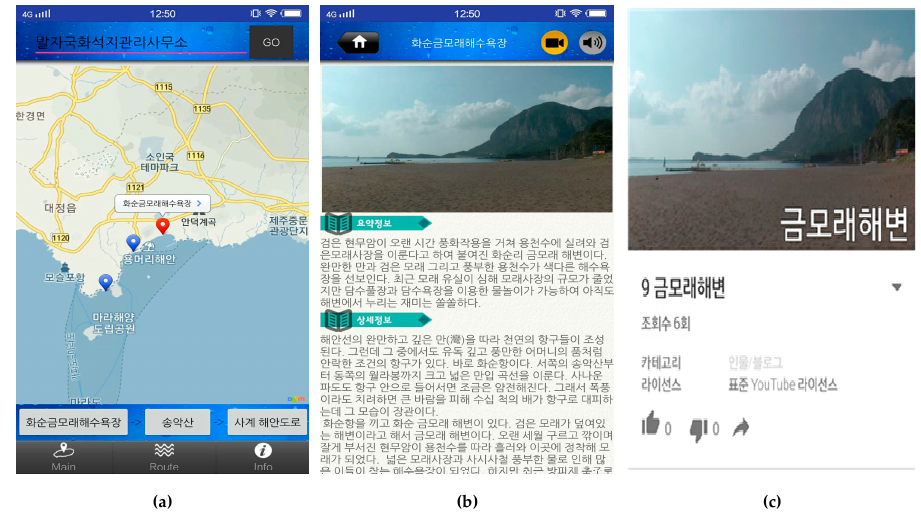
Figure 15. ( a ) travel route with markers; ( b ) travel spot detailed info; ( c ) travel spot introductory video.